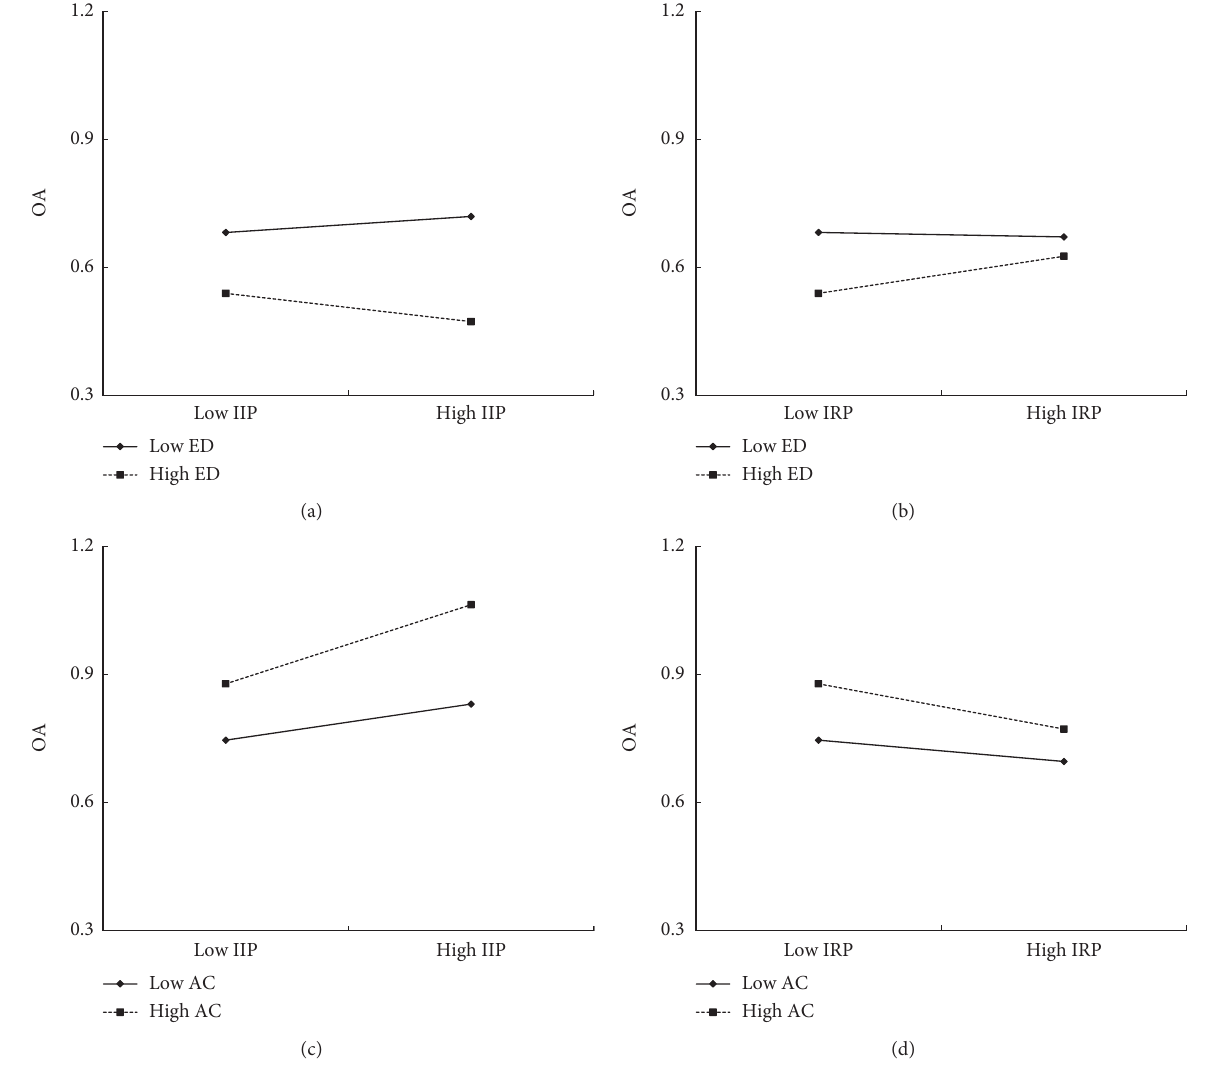
Figure 6: Moderating effects. (a) H3a; (b) H3b; (c) H4a; (d)